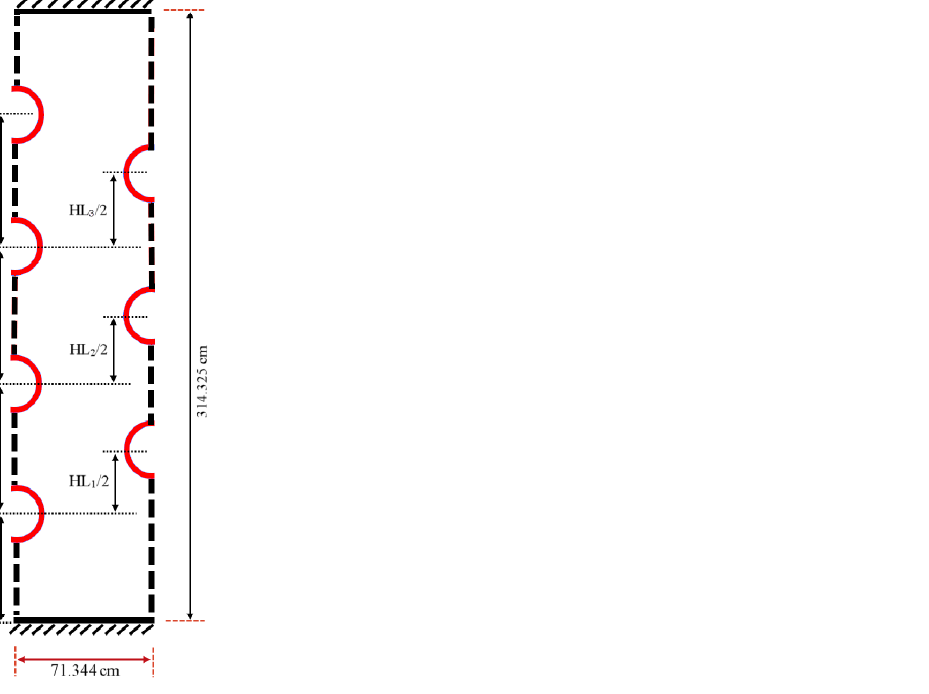
Figure 1. The schematic of the proposed heat exchanger filled with phase change materials (PCMs). The nominal diameter of the tube (D) was 12.7 mm (0.5 in) with an outer diameter of 15.875 mm. The height of the shell was assumed 11D (314.325 mm), and the width of each repeated section was considered 3 3 2 D (74.24 mm). Four variables of HL0, HL1, HL2, and HL3 were defined independently, locating the tubes on the left-hand side of the domain, which was going to be changed to produce a maximum melting rate. The opti- mization process is discussed comprehensively in the results and discussion. The loca- tions of the tubes in the right-hand side of the domain were determined based on the tubes in the opposite side, as illustrated in the figure. The thermophysical conditions of paraffin RT35 (type of PCM) is presented in Table 1. Table 1. Thermal properties of RT35 [28] . Property